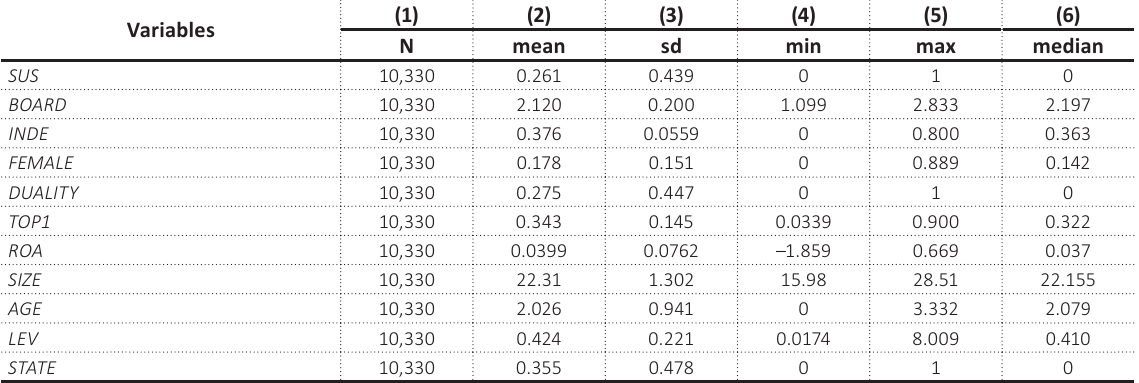
Table 4. Descriptive